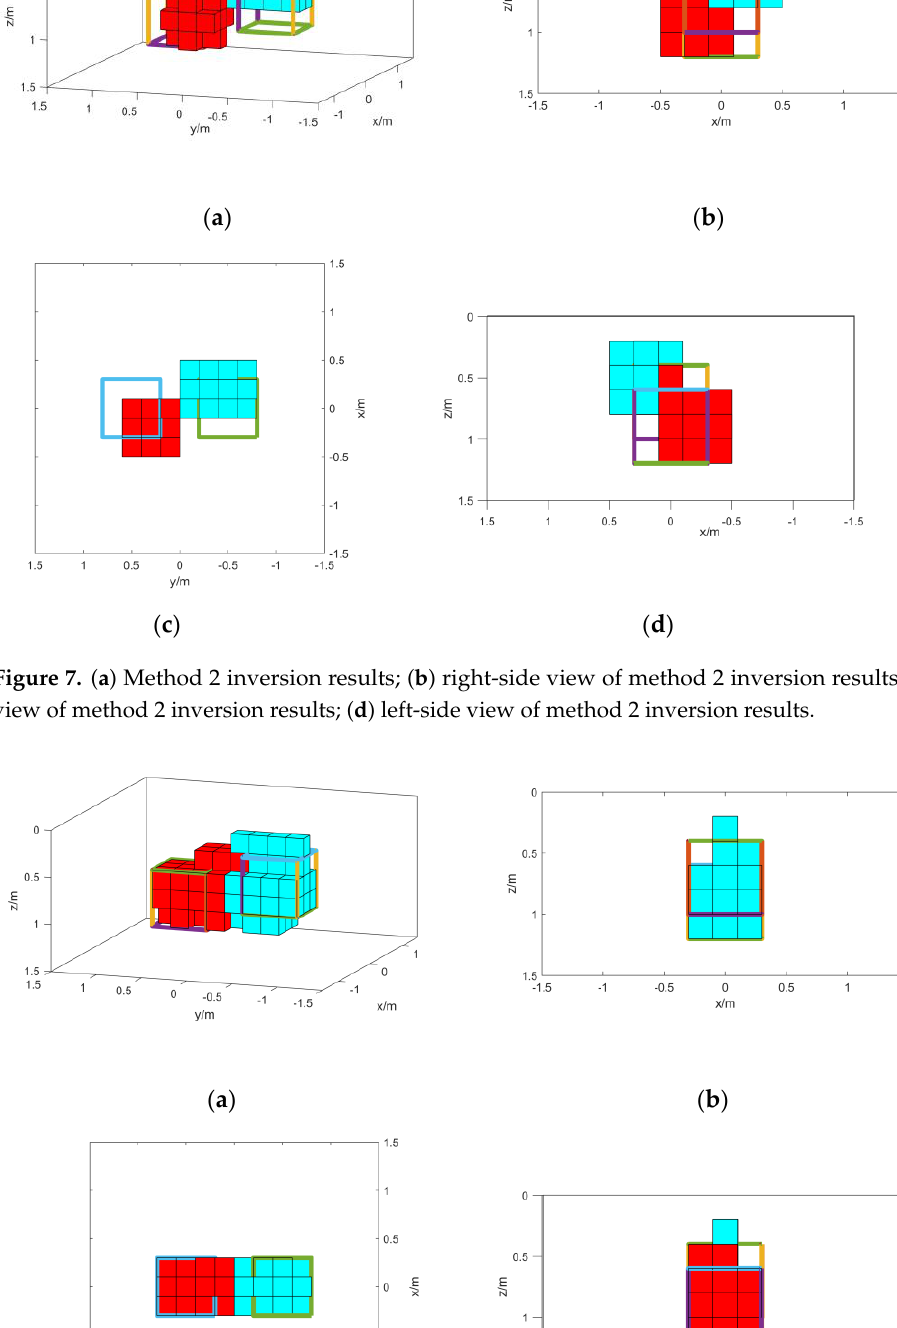
Figure 6. ( a ) Method 1 inversion results; ( b ) right-side view of method 1 inversion results; ( c ) top view of method 1 inversion results; ( d ) left-side view of method 1 inversion results.